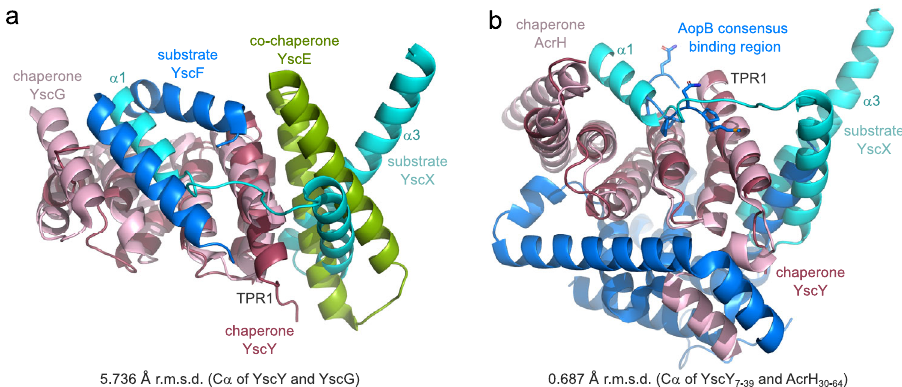
Fig. 8 Comparison of YscXY with other T3S substrate:chaperone complexes. a Superposition of YscX 50 :YscY with YscEFG (PDB: 2P58). The alignment was done using the chaperones YscY (red) and YscG (pink) with an r.m.s.d. of 5.736 Å. The substrates YscX (cyan) and YscF (blue) as well as the co- chaperone YscE (green) are also shown. b Superposition of YscXY with the complex of class II chaperone AcrH (pink) and the major translocator protein AopB (blue), both from Aeromonas (PDB: 3WXX). The alignment was calculated using the fi rst TPR of YscY (residues 7 – 39) and the fi rst TPR of AcrH (residues 30 – 64) with an r.m.s.d. of 0.687 Å to obtain the right register. For clarity, sticks are shown for side chains of AopB where it binds the TPR groove